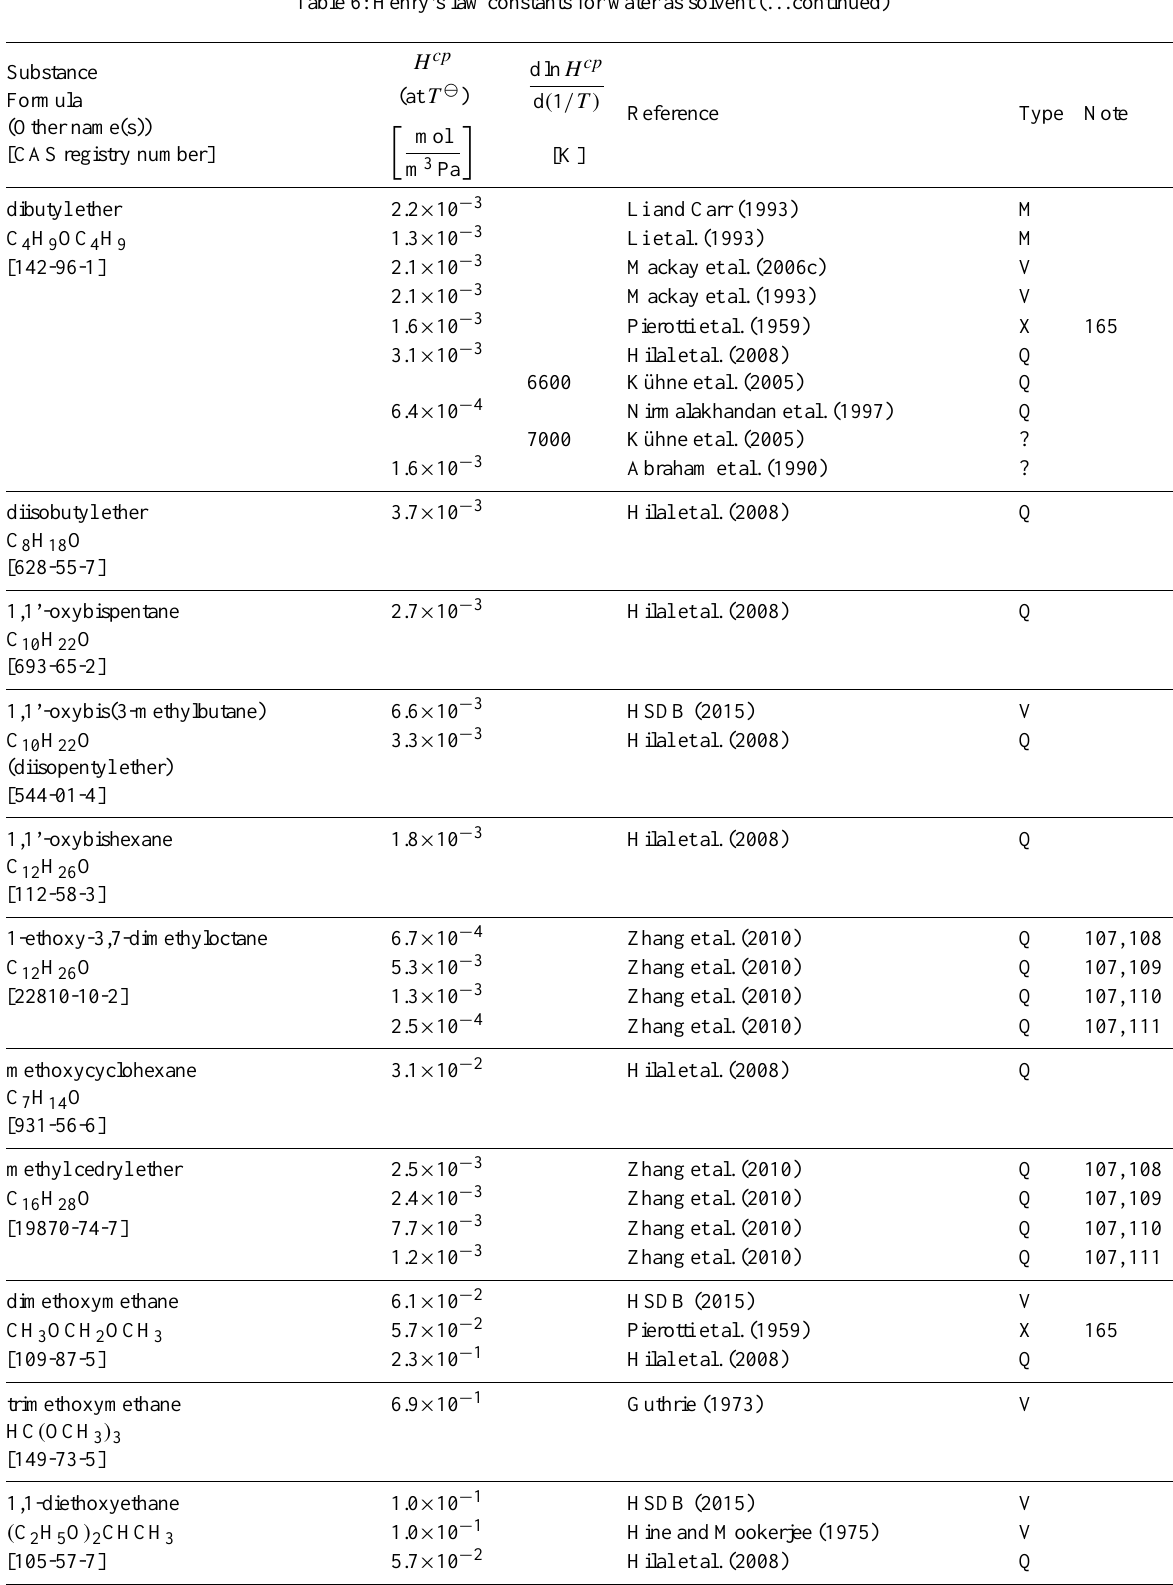
Table 6: Henry’s law constants for water as solvent